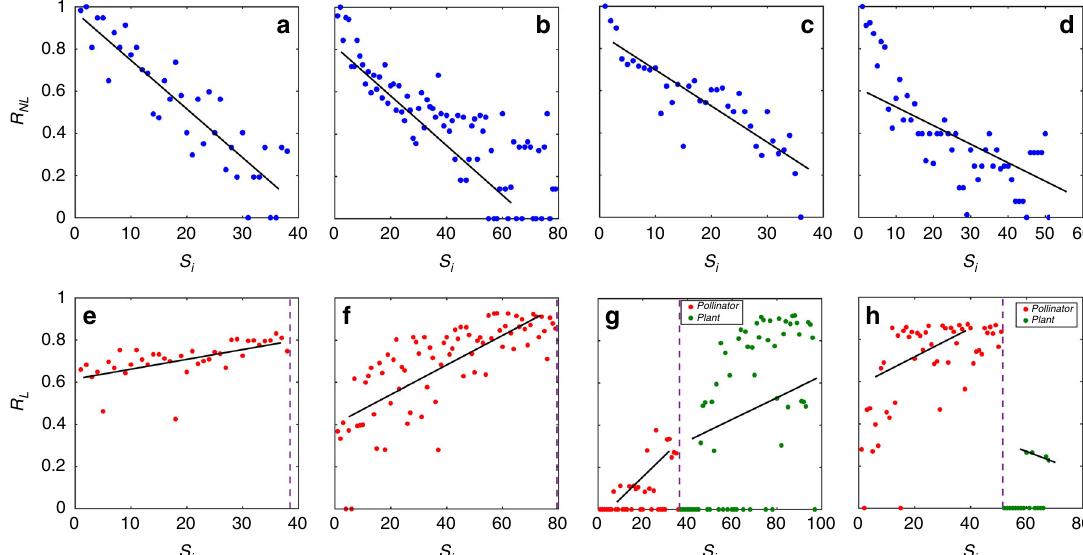
Fig. 2 Contrasting behaviors of nodal importance ranking in nonlinear and linear control. The four empirical networks are labeled as A , B , C , and D with details given in the “ Methods ” section. a – d Nonlinear and e – h linear control importance ranking for networks A − D , respectively. For tipping point control of the nonlinear network in a – d , only the pollinator species are subject to external intervention through the managed maintenance of the abundance of a single species. The nodal index on the abscissa of each panel is arranged according to the degree ranking of the node: from high to low degree values (left to right). For the set of nodes with the same degree, their ranking is randomized. (The dependence of nonlinear and linear control importance on the actual degree value is presented in Supplementary Note 2.) The nonlinear control importance is calculated from Eq. (1) for the parameter setting h = 0.2, t = 0.5, β ð A Þ β ð P Þ β ð P Þ α ð P Þ 1, β ð A Þ 0 ; α ð A Þ 0 : 3, and μ A = μ P = 0.0001. The coupled nonlinear differential equations are solved using the ii ¼ ii ¼ ij ¼ ij ¼ i ¼ i ¼ (cid:2)